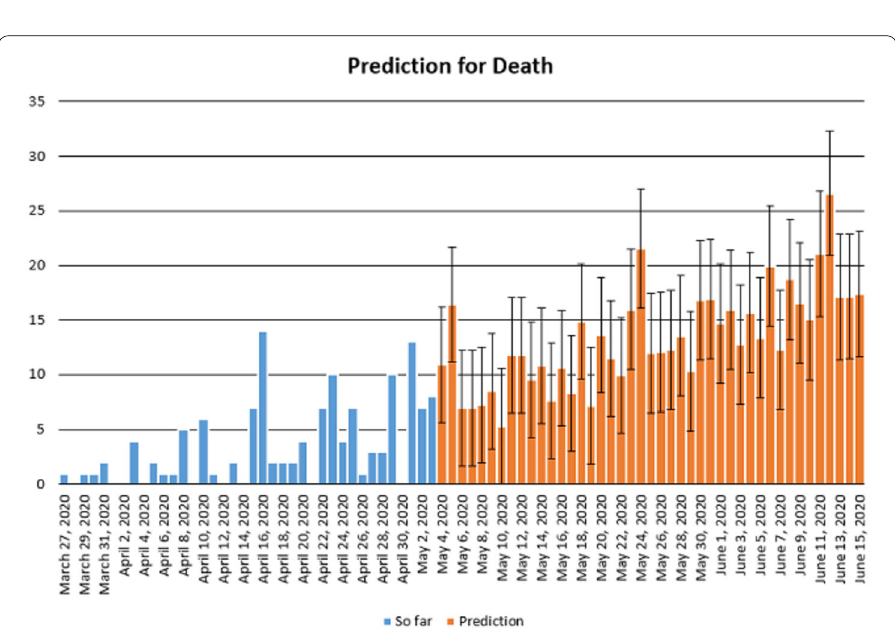
Figure 30 Prediction of daily number of dead in South Africa using forecast sheet with reliability level of